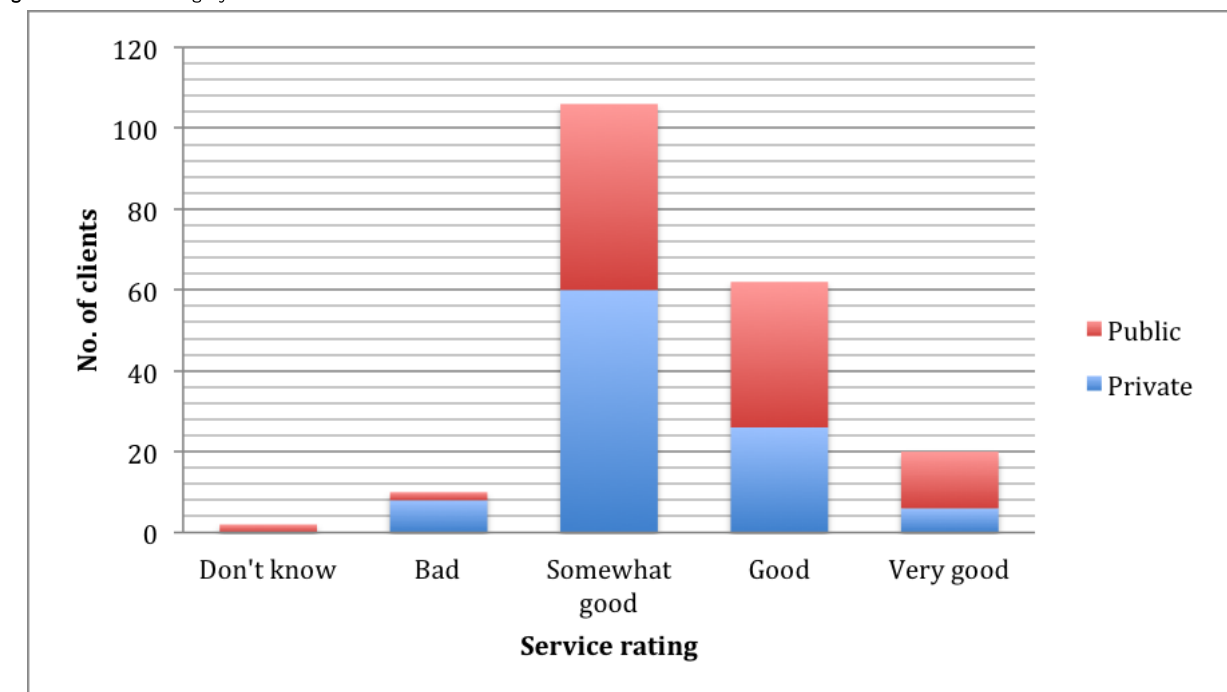
Figure 2. Service rating by